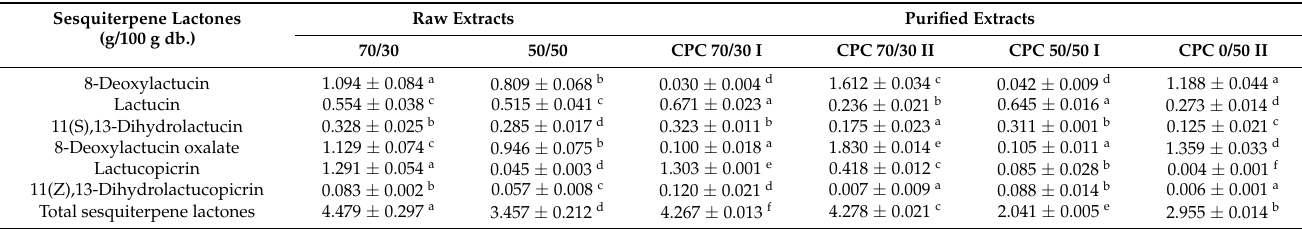
Table 1. Concentration of sesquiterpene lactones from purified and unpurified extract of Cichorium intybus